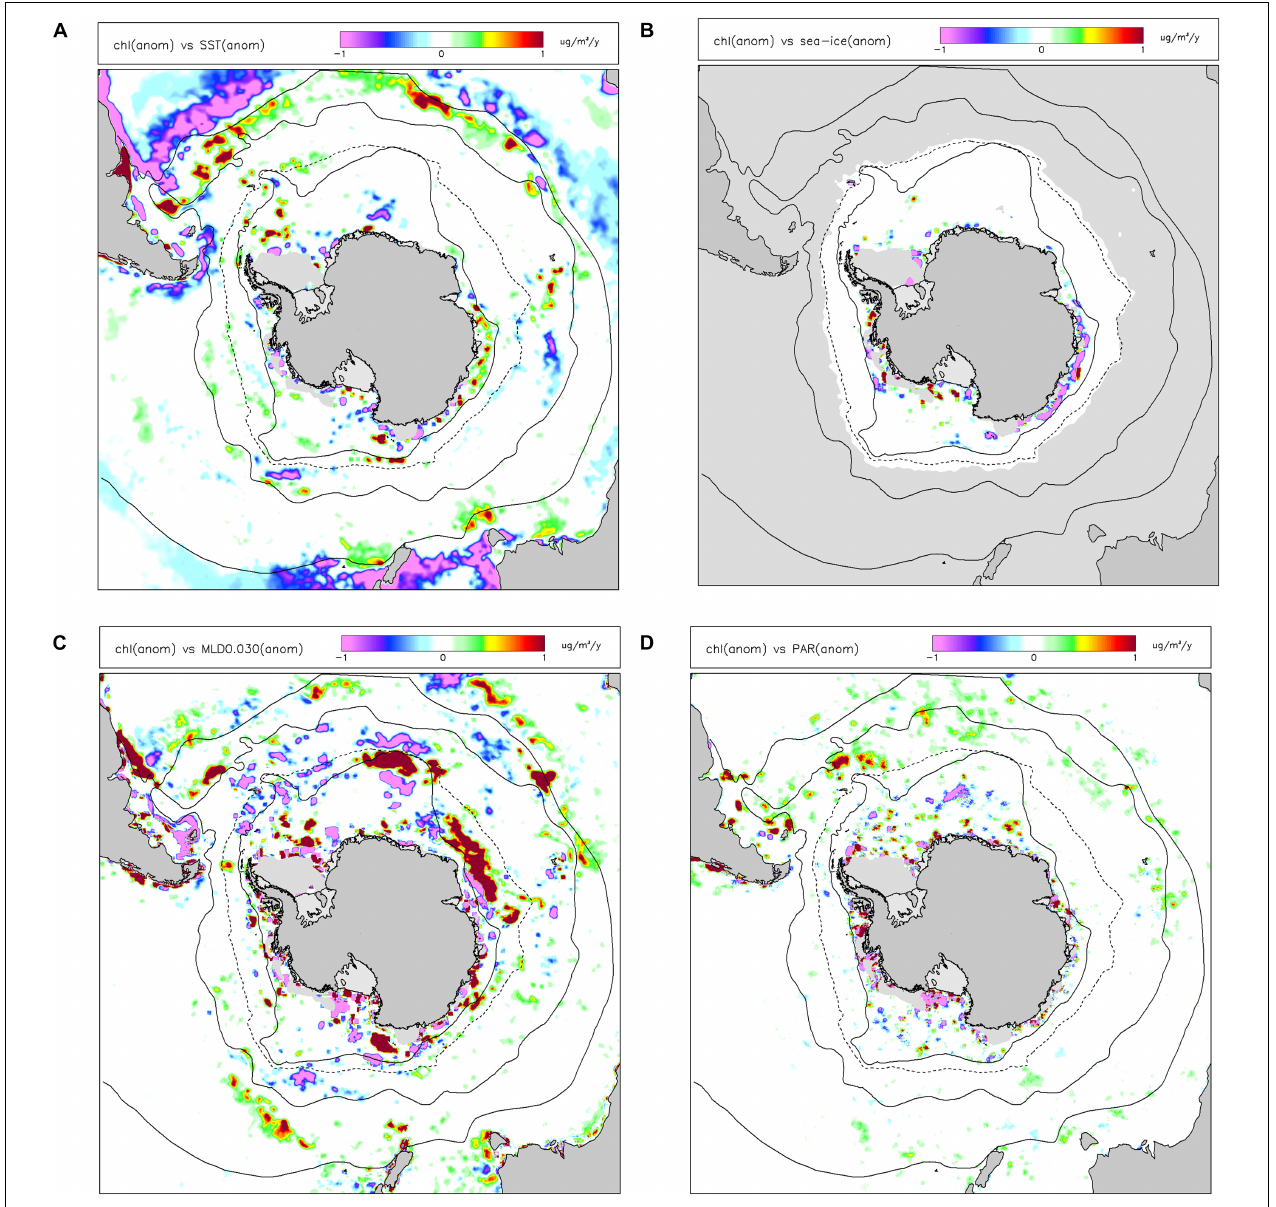
FIGURE 4 | Contribution to linear trends in chlorophyll-a concentration ( chl ) by environmental drivers: (A) sea-surface temperature ( sst ); (B) sea ice concentration ( sea-ice ); (C) mixed layer depth ( mld ); and (D) incident irradiance at the sea-surface ( par ). Other information as Figure 2